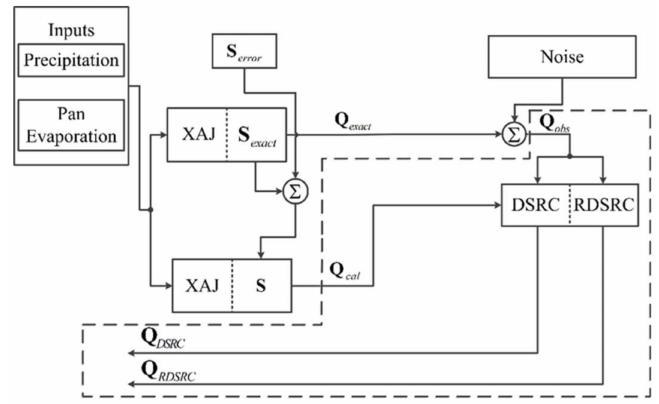
Figure 3. Schematic of the numerical example.